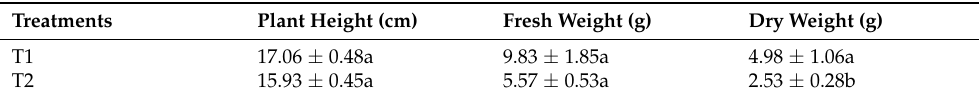
Table 1. Growth parameters (mean ± SE) of H. odoratissimum grown in aquaponic and hydroponic systems for six weeks under greenhouse conditions.